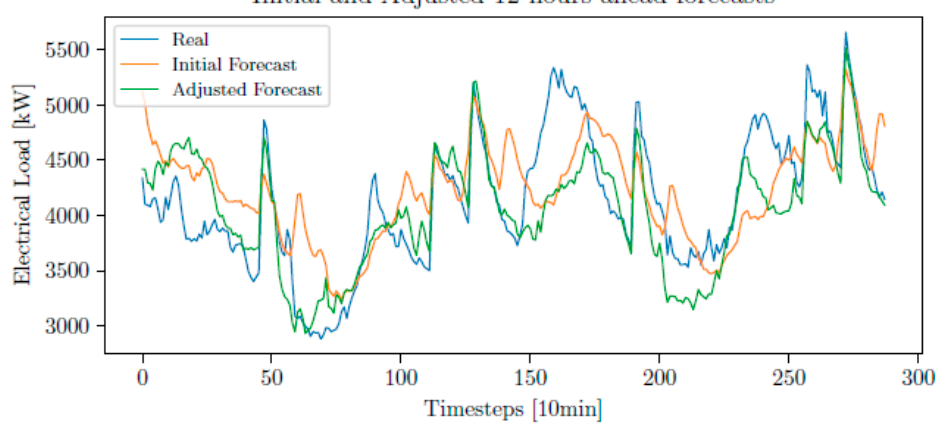
Figure 22. Twelve-hours-ahead adjusted forecasts.